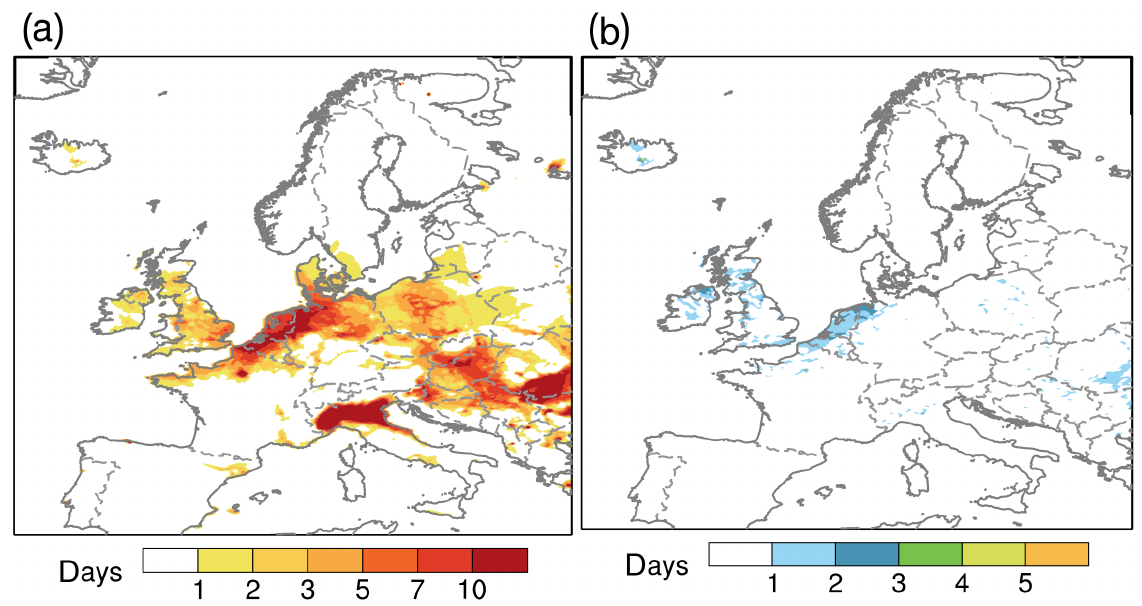
Figure 10. (a) Number of days with exceedances of PM 2 . 5 in the period September through to November 2014, for the bas_hol model simulation. (b) The increase in days of PM 2 . 5 exceedance from no_hol to bas_hol simulation, attributable to volcanic